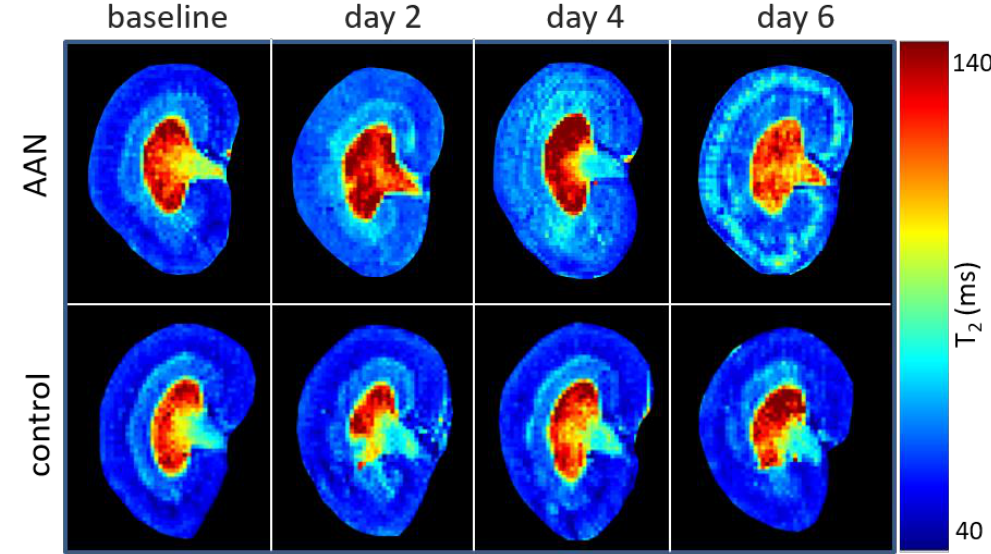
Figure 3. Representative renal T2 maps observed for the AAN group ( upper row ) and for the control group ( bottom row ).